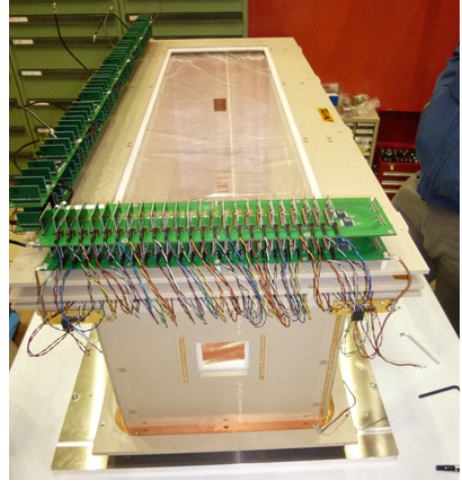
Figure 3. Picture of the TPC [16]. Table 1. Basic parameters of the TPC [11].